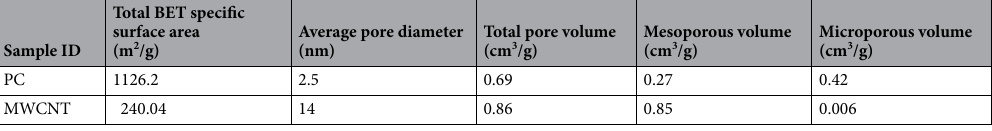
Table 1. Textural characteristics of the PC and MWCNT.